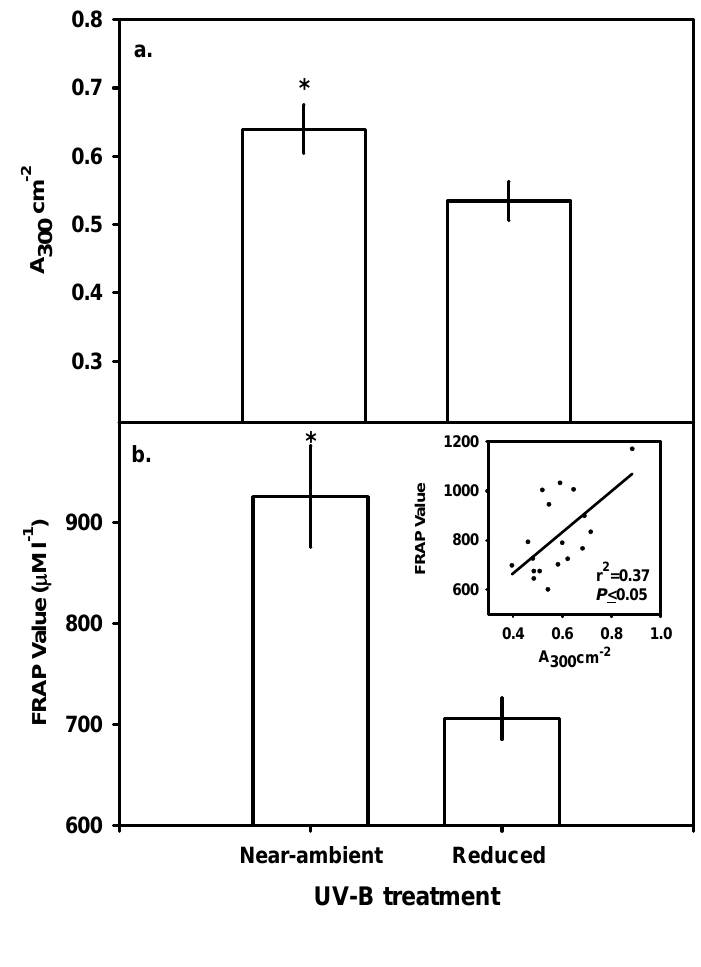
Figure 3. Effects of UV-B reduction on (a) concentration of bulk-soluble phenolics and (b) ferric-reducing antioxidant power (FRAP) values of A. sativa leaf samples under UV- B treatment frames. Values are means of individual plants (n=10). Vertical bars denote ±1 SE and * indicates a significant UV-B treatment effect ( P ≤ 0.05). The inset in (b) shows the significant positive correlation between bulk-soluble phenolic concentrations and FRAP values under both treatments ( P ≤